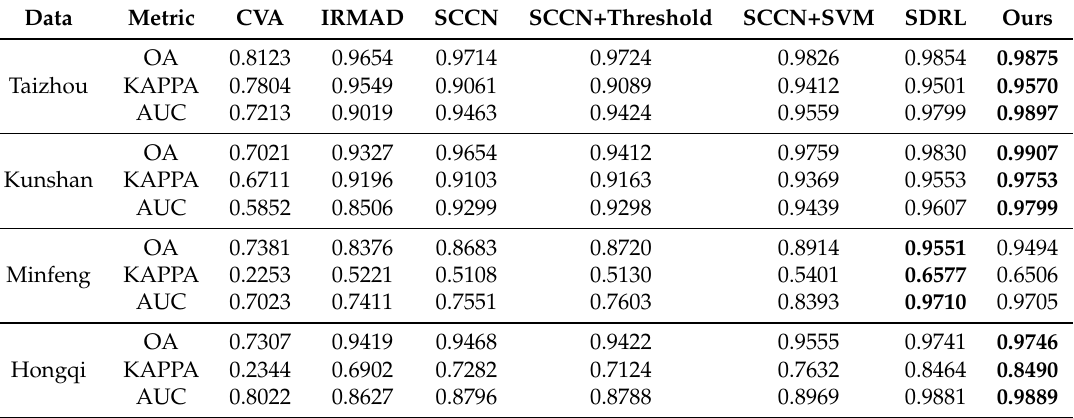
Table 3. Over accuracy, Kappa coefficients, and AUC value over state-of-the-art methods on Taizhou, Kunshan, Minfeng and Hongqi data sets.